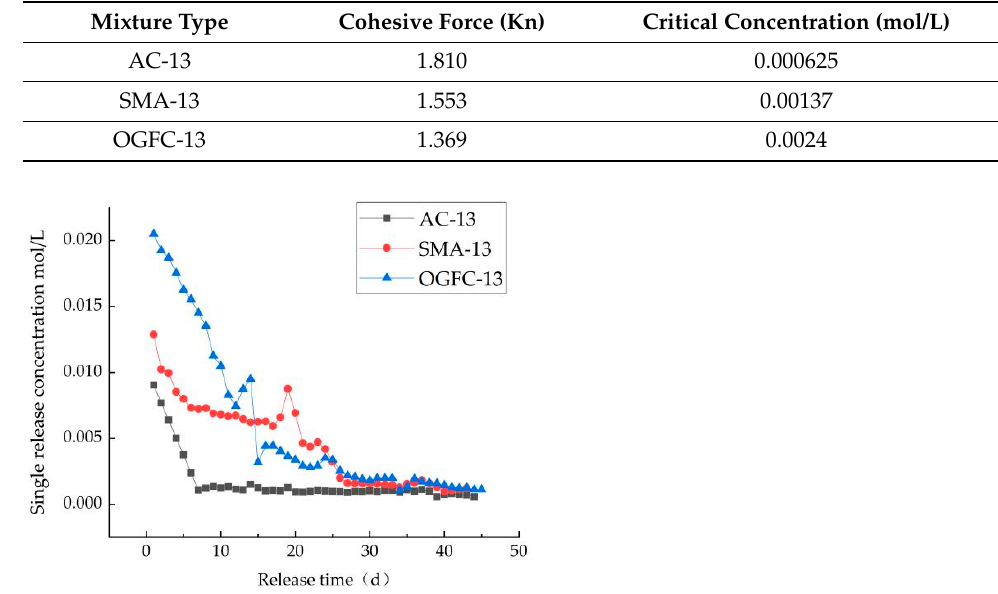
Figure 11. Single release concentration of ions under different types of salt-storage mixtures.